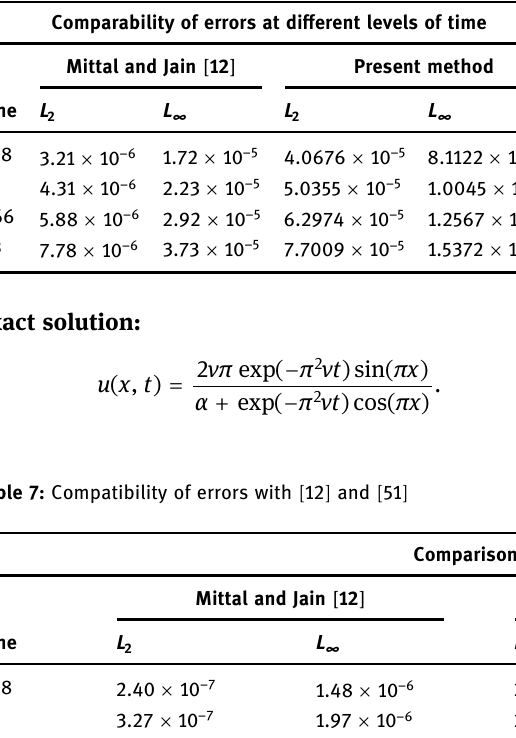
Table 6: Compatibility of error norms with [ 12 ] , for = t Δ 0.0001 , = ν 0.002 Comparability of errors at di ff erent levels of time Mittal and Jain [ 12 ]